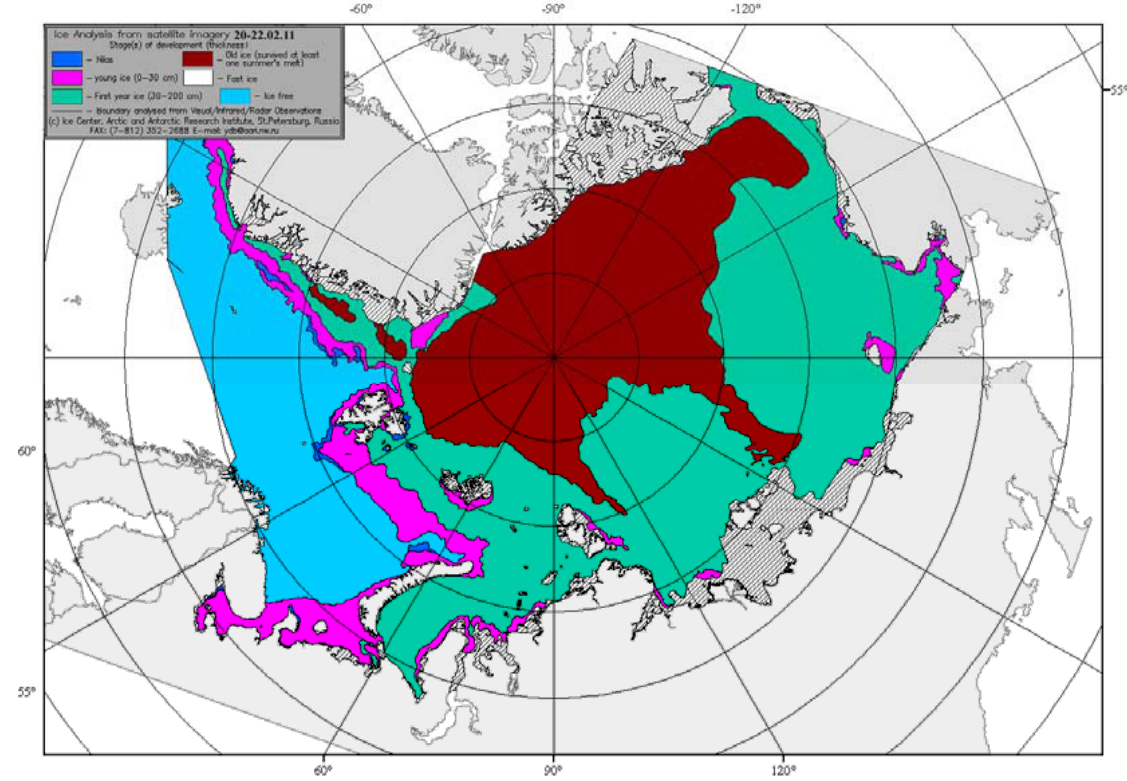
Fig. 13. The Arctic Ocean ice chart for the period 20–22 February 2011, issued by Arctic and Antarctic Research Figure 13. The Arctic Ocean ice chart for the period 20-22.02.2011, issued by Arctic and Antarctic Research Institute.